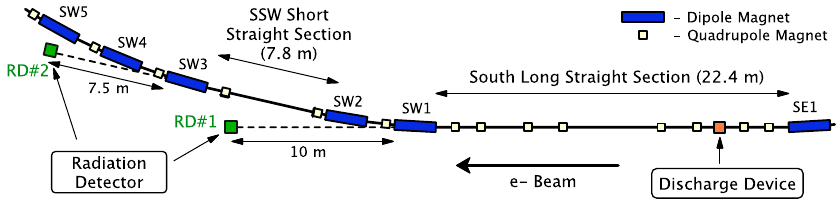
electrode.FIG. 4. (Color) Layout of the experimental setups in the PF-AR storage ring.